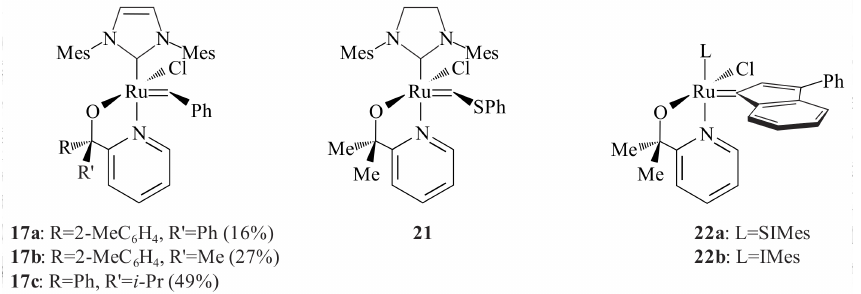
Figure 5. NHC pyridinyl alcoholato ruthenium carbene